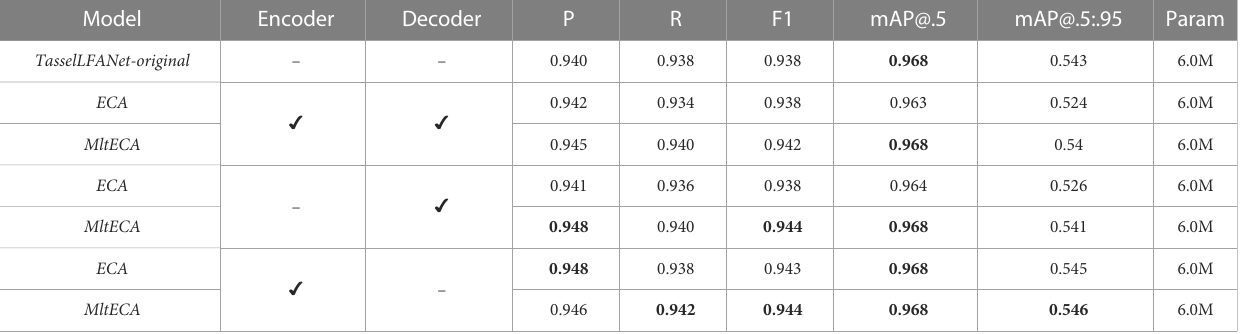
TABLE 3 Ablation experiments of ECA attention and Mlt-ECA